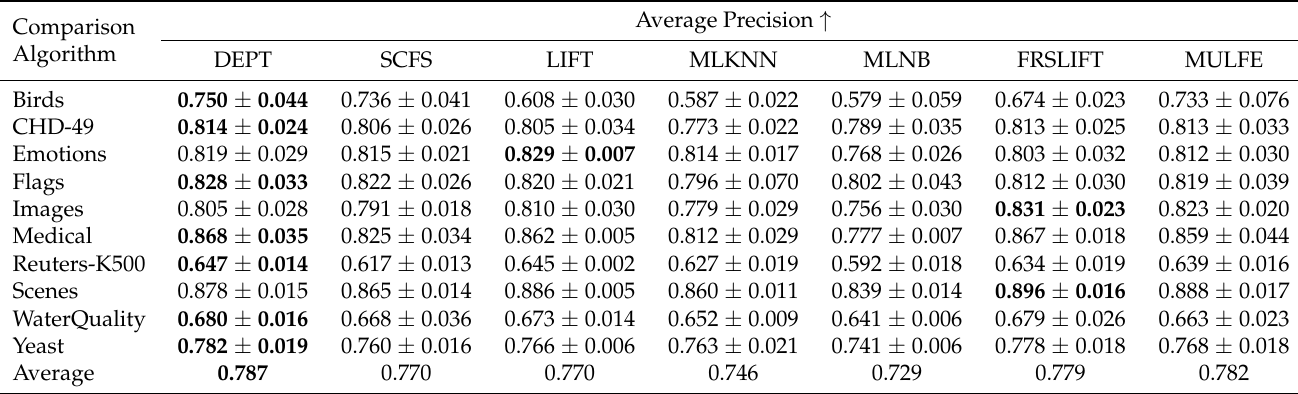
Table 2. Experimental results of each compared algorithm (mean ±